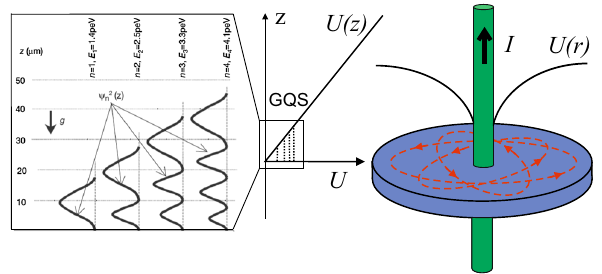
Fig. 1 On the right side, a schematic representation of the Magneto- Gravitational trap (MGT) for neutral particles with a magnetic moment is shown. The linear gravity potential and quantum reflection from the horizontal mirror (blue) confine particles in the vertical direction. The particle’s wave functions in four lowest GQSs are shown in the insert on theleftasafunctionoftheheightabovethemirror.Themagneticfieldof a vertical linear wire carrying an electric current I and the centrifugal acceleration confine particles in the horizontal plane. The magnetic field is inversely proportional to the distance to the wire. The particle adiabaticallymoves along closed ellipticaltrajectories (red dashed lines around the wire), similar to the orbital motion of planets around the